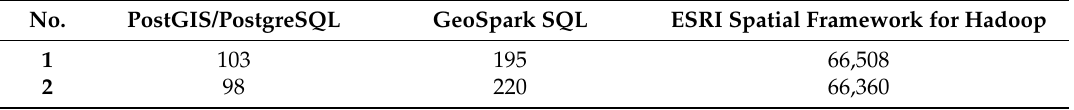
Table 9. Performance of point queries (in milliseconds).